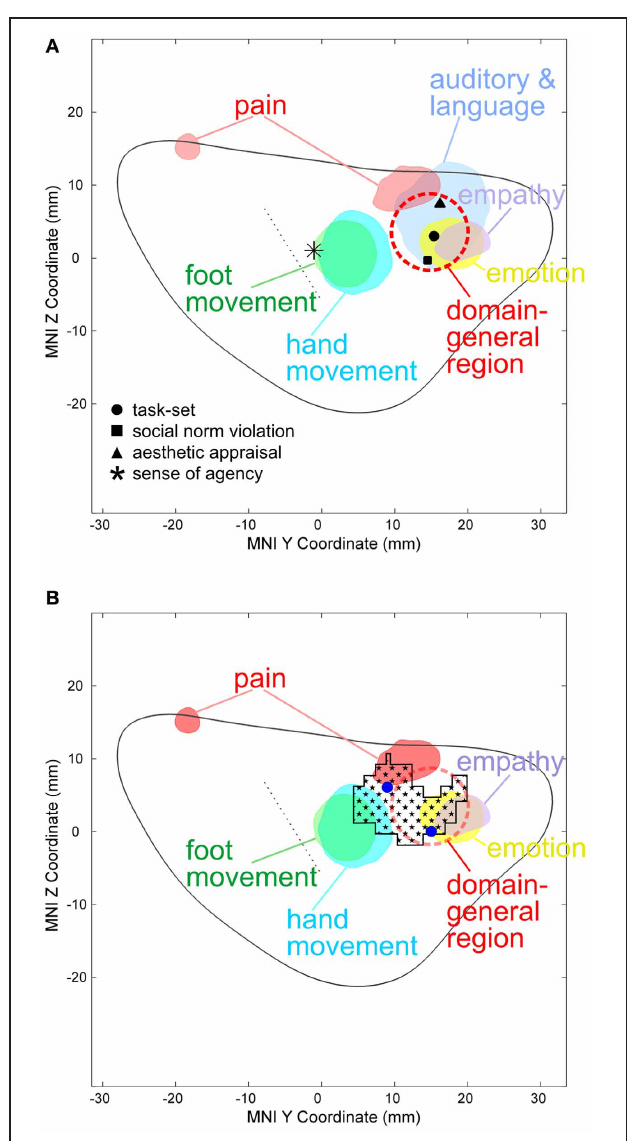
FIGURE 2 | (A) Activation likelihood estimate (ALE) findings in the left insula and the MNI z coordinates (on the y-axis) and y coordinates (on the x-axis) related to the physical pain investigated with fMRI (red), emotion (yellow), empathy for pain (purple), hand (turquoise), and foot movement (green). The solid gray line indicates the mean outline of the left sagittal insula and the dashed gray line the central sulcus of the insula dividing the insula in an anterior and posterior part (see methods for more details). Importantly, studies on emotion in healthy individuals entering this ALE analysis did not include insula-coordinates which were related to the measurement of peripheral physiological changes. In a recent meta-analysis responses related to peripheral physiological changes resulting from emotional experiences were located in the ventral anterior insular cortex (Mutschler et al., 2009). Pain-related maximal ALE were found in the posterior insula (left) and in the dorsal anterior insula [left and right, see reference Mutschler et al. (2012) for more details]. Response peaks related to task-set processing based on conjoint analysis of data from 10 different fMRI tasks are indicated by red dashed circles [that is the approximate position of the domain-general region (DGR) of the insular cortex described in reference Dosenbach et al. (2006)], and peaks related to social norm